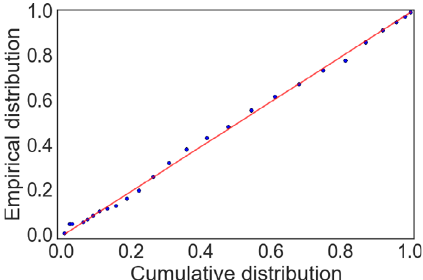
Fig. 5. Quantile – quantile plot of the empirical distribution of p - values (dotted) vs. a uniform distribution (solid lines) of our data after applying von Neumann ’ s bias removal algorithm.